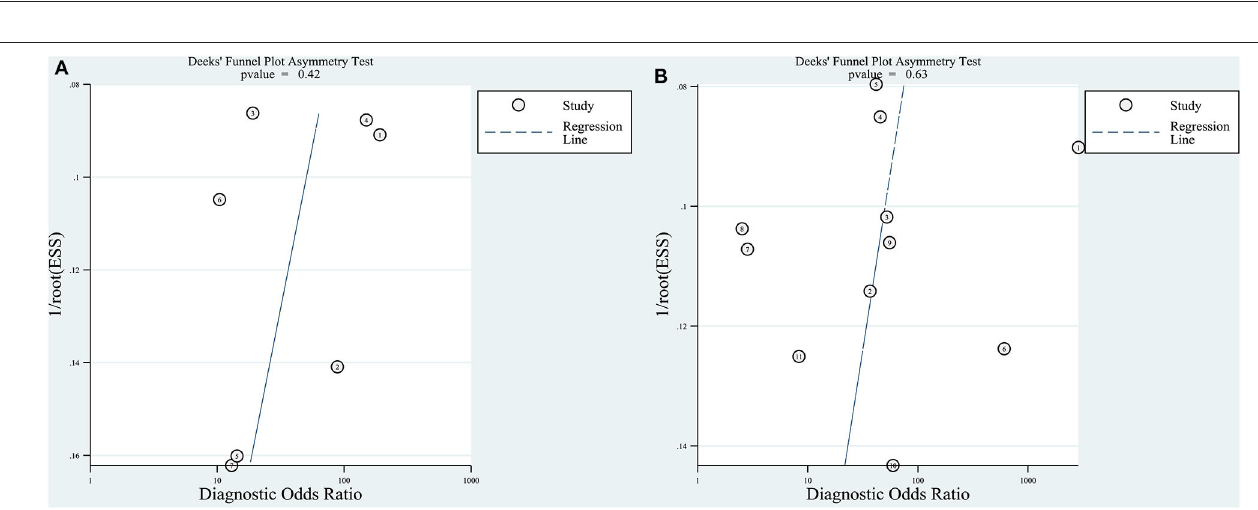
FIGURE 3 | Sensitivity and specificity plotted in summary receiver operating characteristic (SROC) curves of the included studies. Area under the curve (AUC) was calculated to quantitatively assess the pooled result. (A) Quantitative elastography studies; (B) qualitative elastography studies. SENS, sensitivity; SPEC, specificity.